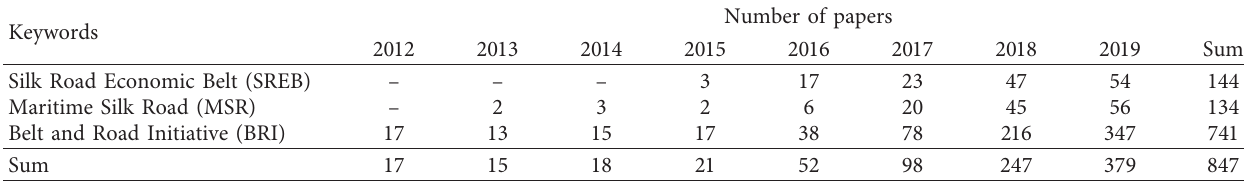
Table 2: Number of papers on the Belt and Road in SSCI/SCI/SCIE journals.